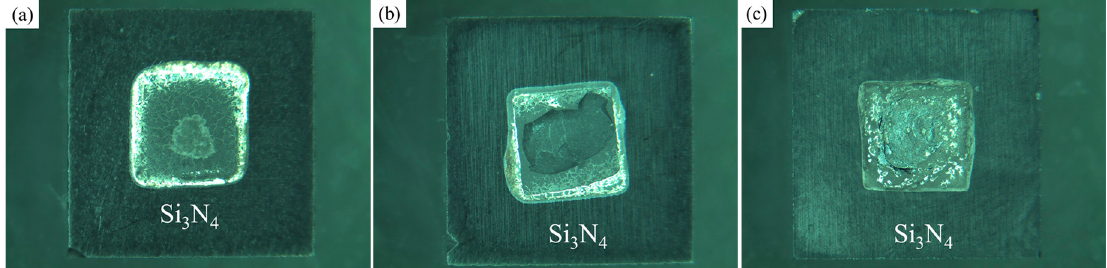
Figure 7. Fracture modes of TiAl/AgCu/Si 3 N 4 joint brazed at different temperatures. ( a ) 1153 K, ( b ) 1173 K, ( c ) 1193 K.